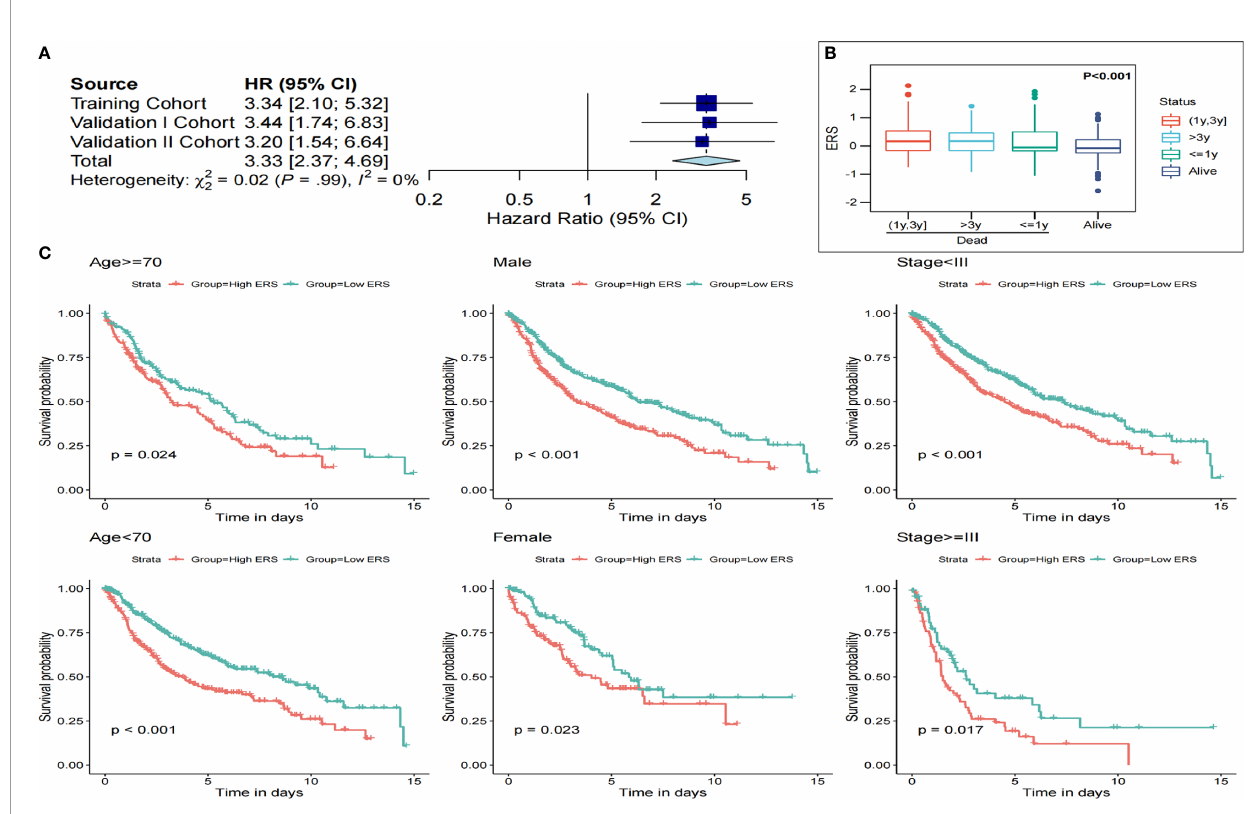
FIGURE 5 | ERS is a valuable indicator of poor survival in the pooled cohorts and subgroups. (A) Meta-analysis results showed ERS to be a valuable prognostic marker. (B) The ERS score was markedly raised in the dead patients, especially in those who had a shorter survival. (C) ERS distinguished high-risk patients in different subgroups, including age, gender, and AJCC